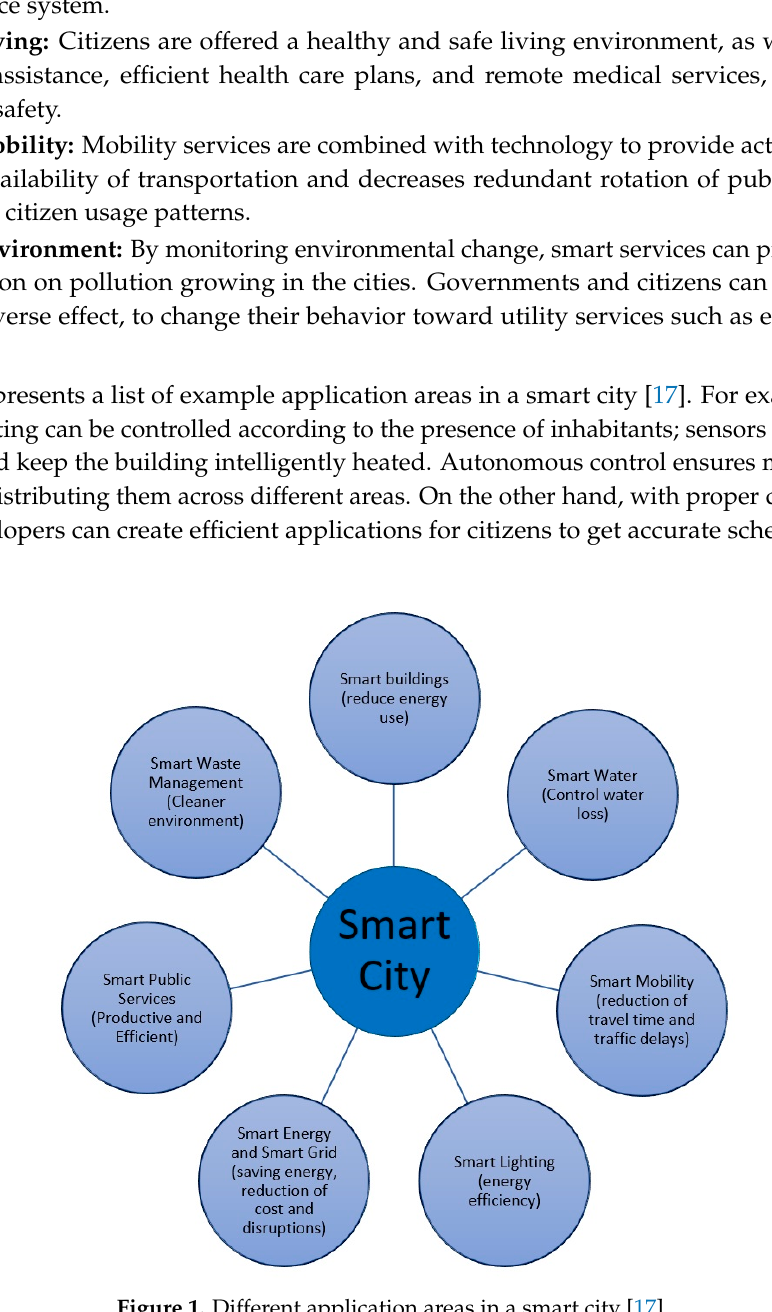
Figure 1. Different application areas in a smart city [17].